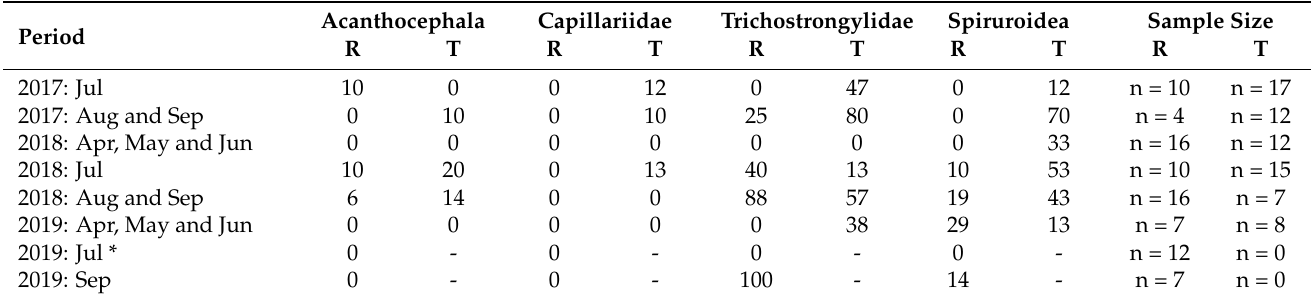
Figure 3. Seasonal dynamics for the studied period in the prevalence of the observed helminth taxa in the resident individuals summarized by month. Cells below the graph represent the period of sampling by month, with the corresponding sample size. Table 4. Prevalence (%) of helminth taxa found in the coprological samples of resident and translo- cated ground squirrels. R = resident, T = translocated. Notes: The “Jul” datasets contain samples at the moment of translocation. * Only juvenile individuals were captured; therefore, the results were not included in the analysis.